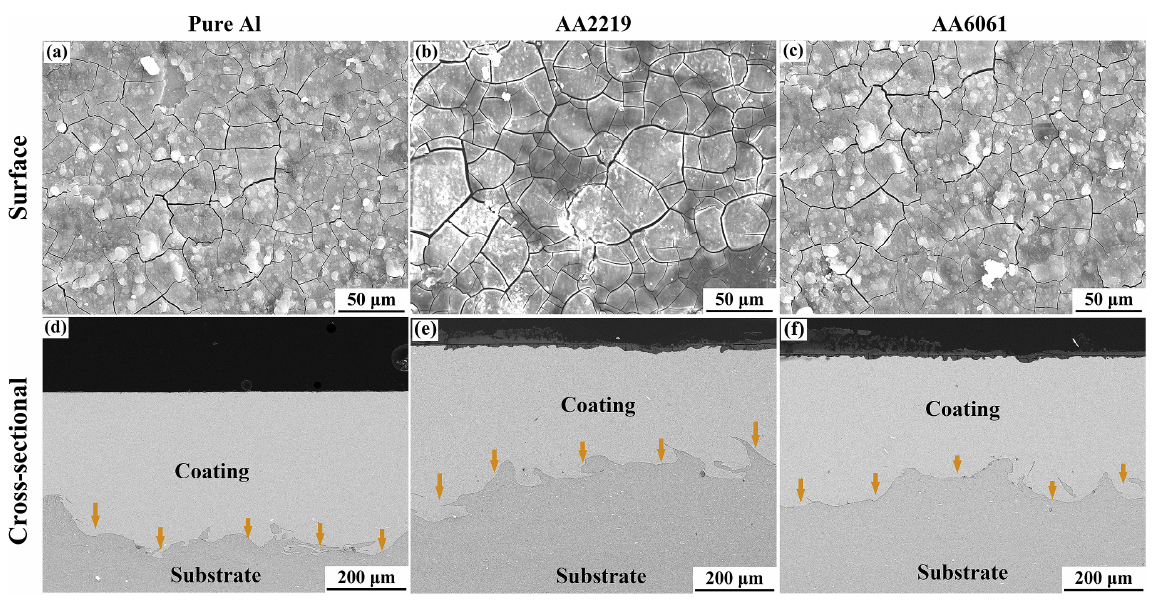
Figure 4. The surface morphologies and cross-sectional microstructures of the MF-CS Al-based coatings after 1000 h immersion. Pure Al ( a , d ), AA2219 ( b , f ), and AA6061 ( c , e ) [48].